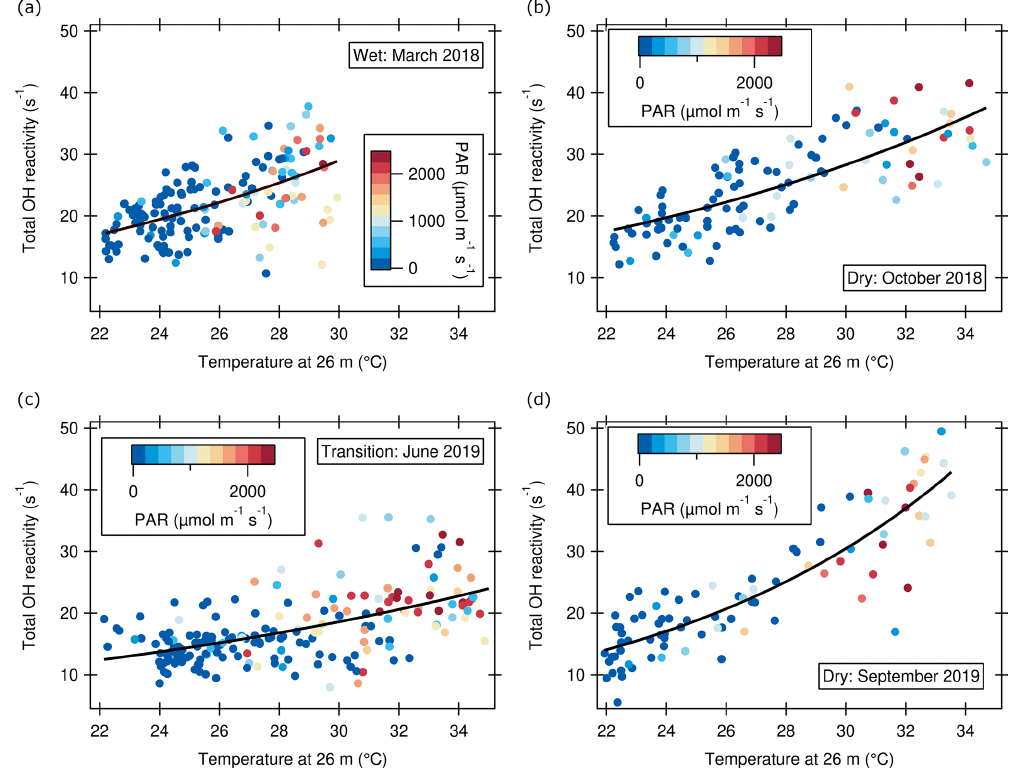
Figure 7. Hourly averages of total OH reactivity at 80ma.g.l. at the ATTO tall tower as a function of temperature at canopy height. (a) Wet season (March 2018); fit equation: R = 20 . 8exp ( 0 . 066 ×[ T − 25 ] ) . (b) Dry season (October 2018); fit equation: R = 20 . 9exp ( 0 . 060 × [ T − 25 ] ) . (c) Transition season (June 2019); fit equation: R = 14 . 4exp ( 0 . 051 ×[ T − 25 ] ) . (d) Dry season (September 2019); fit equation: R = 18 . 8exp ( 0 . 097 ×[ T − 25 ] ) . PAR is photosynthetically active